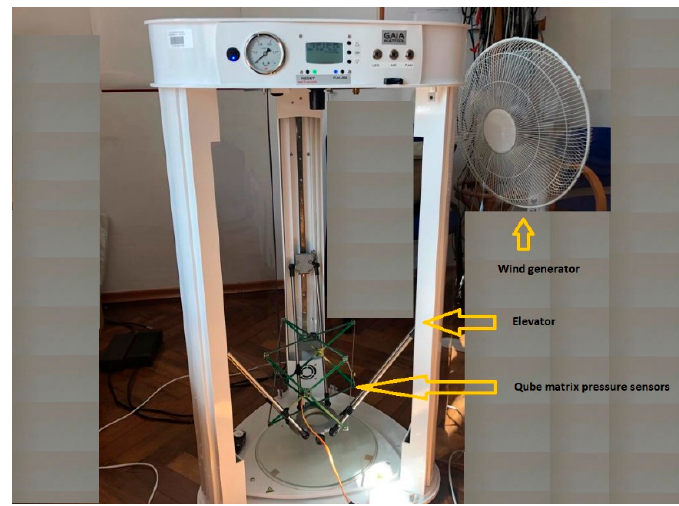
Figure 3. Photograph of the measurement system.